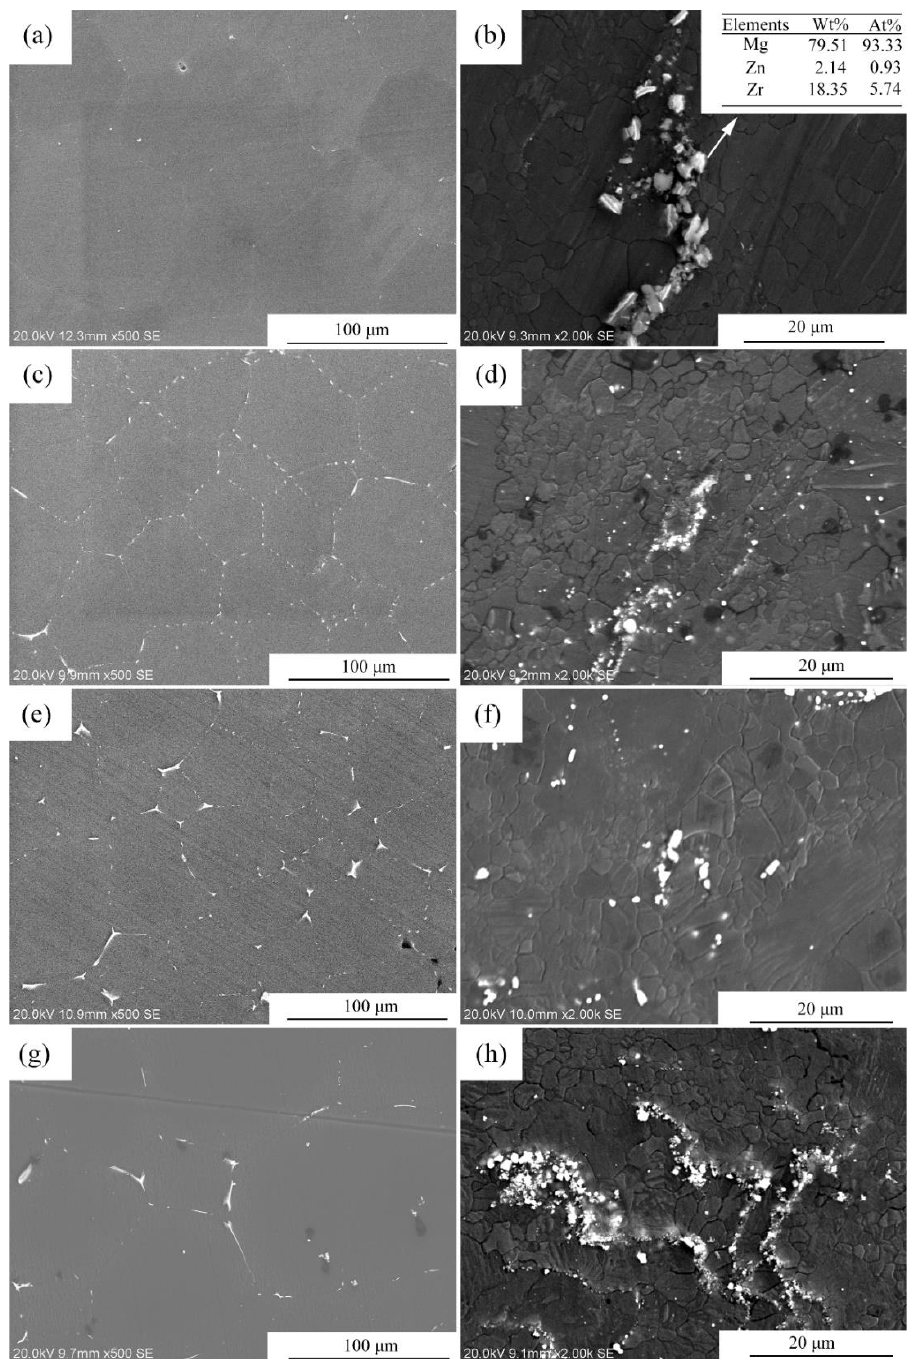
Figure 4. Microstructures of the four-pass extruded alloys: ( a , b ) the as-cast and the four-pass extruded Mg-2Zn-0.5Zr alloy; ( c , d ) the as-cast and the four-pass extruded Mg-2Zn-0.5Gd-0.5Zr alloy; ( e , f ) the as-cast and the four-pass extruded Mg-2Zn-0.5Nd-0.5Zr alloy; ( g , h ) the as-cast and the four-pass extruded Mg-2Zn-0.5Y-0.5Zr alloy.